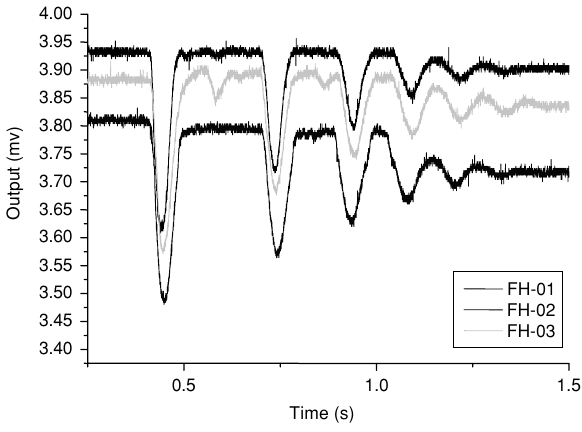
Figure 13 Drop test results of MPD sensors for three